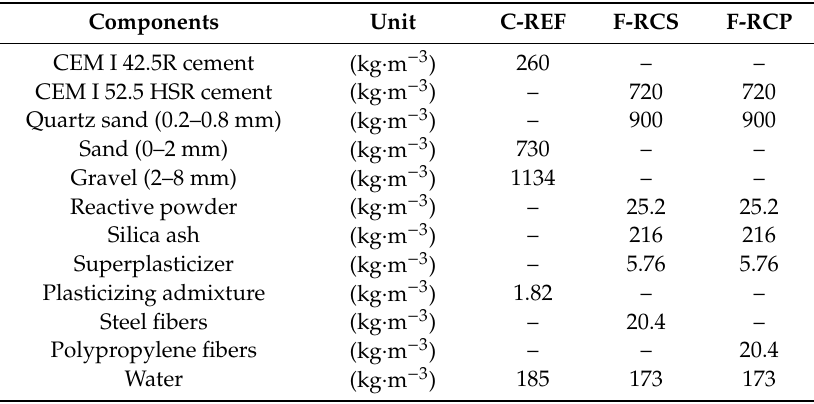
Table 2. Composition of concrete mixtures.